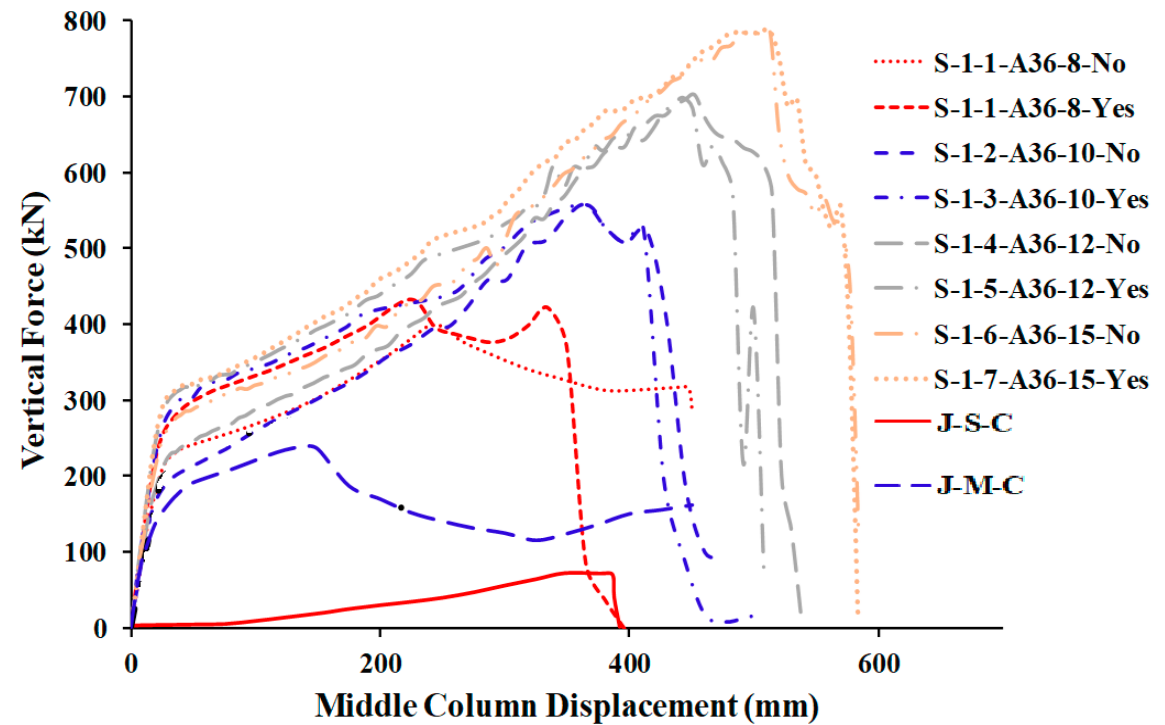
Figure 15. FEM force-displacement response for all A36 steel-specimens.